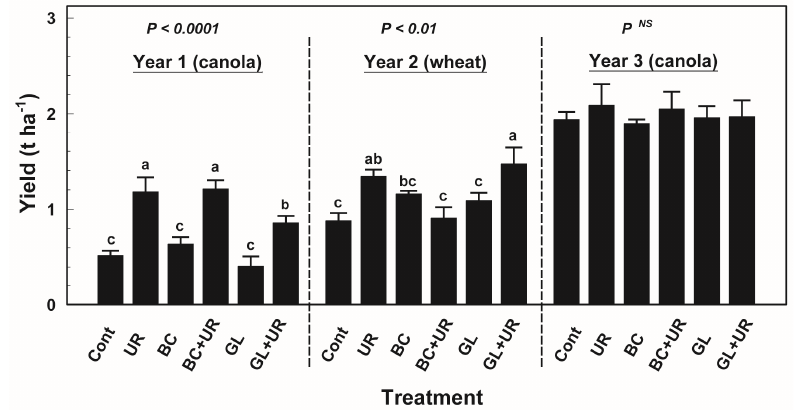
Figure 1. Yield responses to treatment application during a 3 ‐ year field study in Central Butte, SK. Treatments were applied once in spring 2009 and were control (Cont), urea (UR), biochar (BC), biochar plus N (BC + UR), glycerol (GL) and glycerol plus N (GL + UR). For a year, bars sharing the same letter among treatments are not significantly different according to LSD test ( p ≤ 0.1). Errors bars represent standard error of mean ( n = 4). NS denotes not significant at p ≤ 0.1.